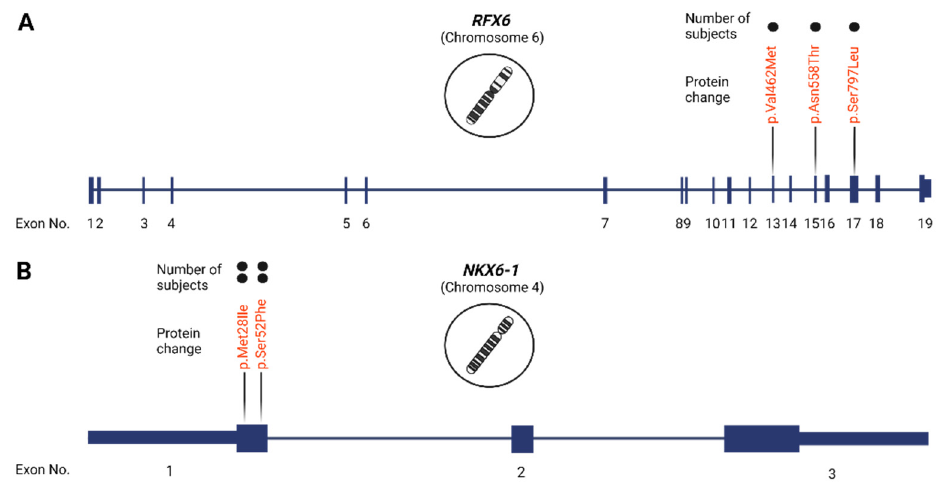
Figure 2. Identified mutations in RFX6 and NKX6 ‐ 1 . The locations of potentially novel MODY ‐ causing mutations in ( A ) RFX6 and ( B ) NKX6 ‐ 1 genes. The number of participants carrying each mutation is presented by a dot above each gene mutation.